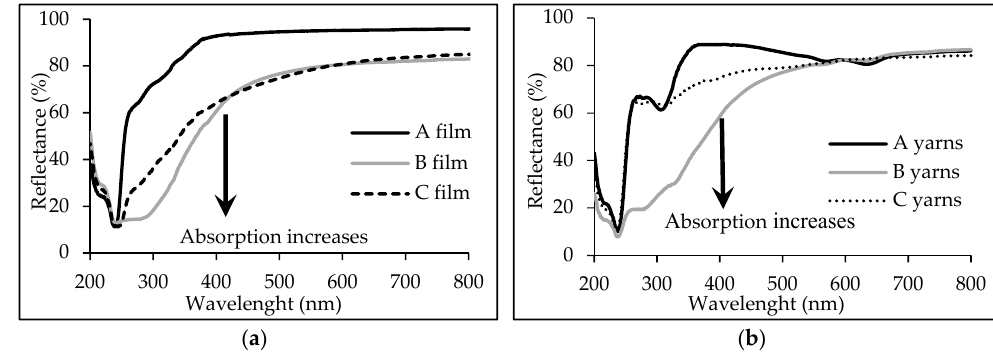
Figure 5. UV-vis spectra analysis of: ( a ) PLA films (A—pure PLA polymer; B—PLA polymer modified with myrrh ethanolic extract; C—PLA polymer modified with myrrh aqueous extract) and ( b ) PLA multifilament yarn from (A—pure PLA polymer; B—PLA polymer modified with ethanolic myrrh extract; C—PLA polymer modified with aqueous myrrh extract).